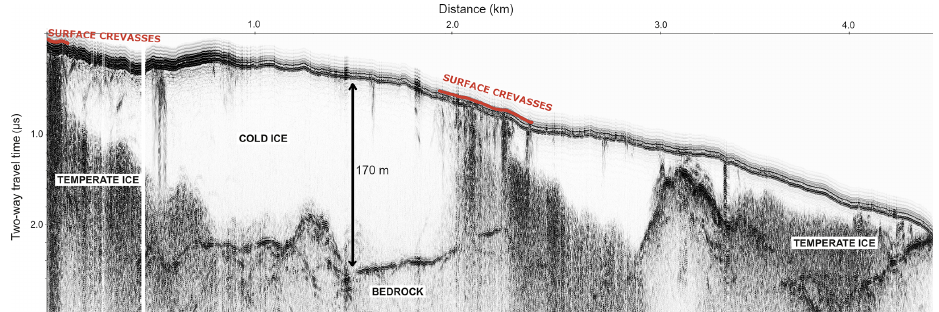
Figure 2. The 30MHz radar profile measured in 2015 along the red dashed line in Fig. 3a. This profile shows the presence of both cold ice (no reflection) and temperate ice (strong scattering). Table 1. Parameters of the surface model for enthalpy boundary conditions. Name Symbol Values Units Residual water saturation